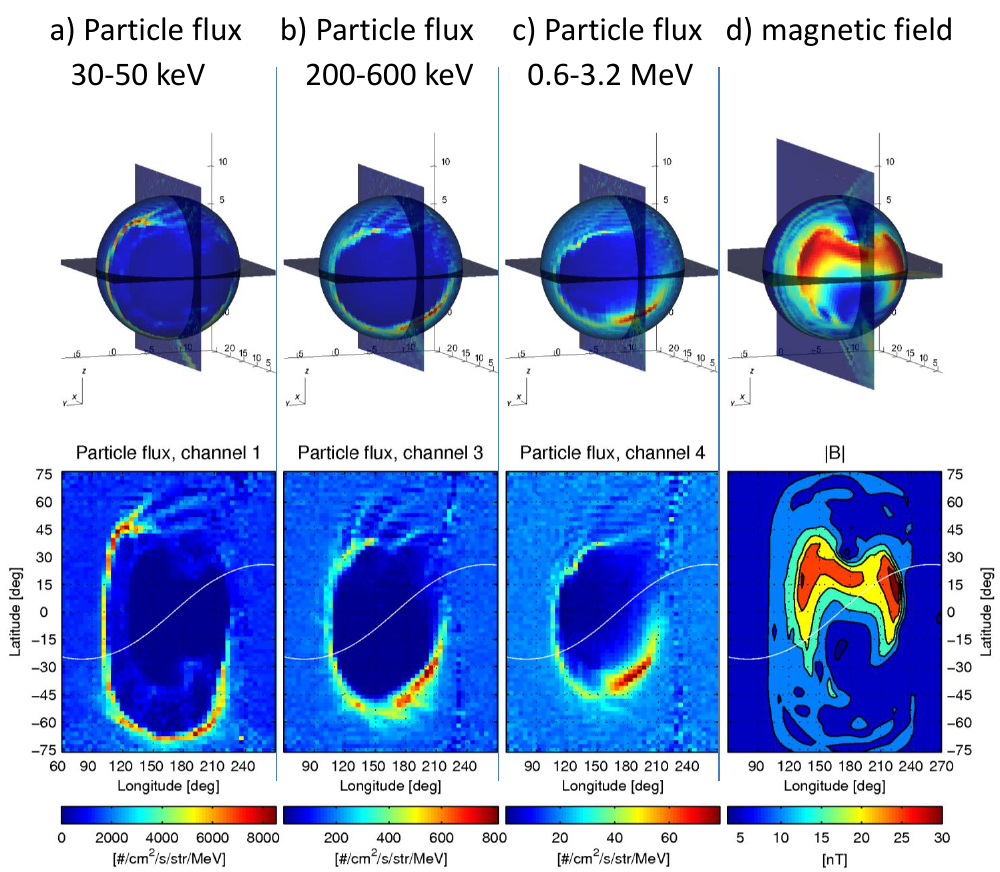
Fig. 8. The simulated normalized particle flux of energetic solar wind protons on a spherical shell with r = 2 . 8 R M from the centre of Mars, which corresponds the radius of the Phobos-2 circular orbit. In the top panels the flux is shown on the surface of the orbit shell and the view point is in the dusk hemisphere ( y > 0) on the nightside ( x < 0) where the region close to BS IN is clearly visible. In the bottom panels the same data are shown in a longitude-latitude map, where longitude is defined as the angle from the positive x-axis towards the positive y-axis and the latitude as elevation from the Martian orbital plane + 90 ◦ being on the + z-axis. Therefore, the (latitude, longitude) point (0 ◦ , 180 ◦ ) in the centre of the figure is on the x-axis in the Martian tail. The initial energies of the protons were (a) 30–50keV, (b) 200–600keV and (c) 0.6–3.2MeV (from the initial velocity distributions shown in Fig. 3b). The ions were launched along the IMF in the moving solar wind frame. The red colour indicates increased flux near the bow shock, and the dark blue elliptical region at the centre of the figure indicates a low flux region, the magnetic shadow. Also the total magnetic field on the spherical shell is shown for comparison in panel (d) . The highest magnetic field regions are the magnetic field tail lobes. The white curves in the bottom panels show the trajectory of Phobos-2 in the analysed case. In the figures the spacecraft moves from left to right. Note that the vertical stripes in flux density around 230 ◦ longitude are artefacts resulted from low particle statistics in the region on the spherical shell, where the ion beams move almost tangentially with respect to the collecting spherical